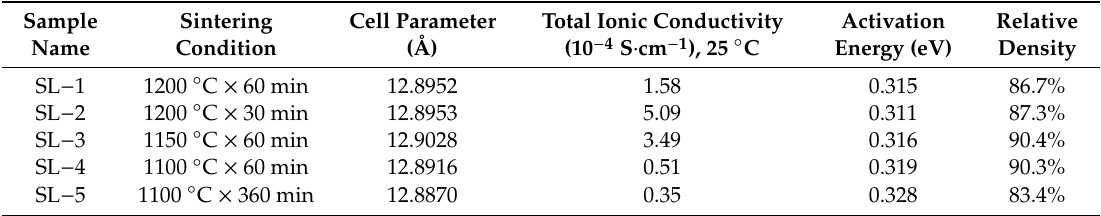
Table 2. Sintering condition, cell parameter, total ionic conductivity at 25 ◦ C, activation energy, and relative density of LLZNO ceramics.